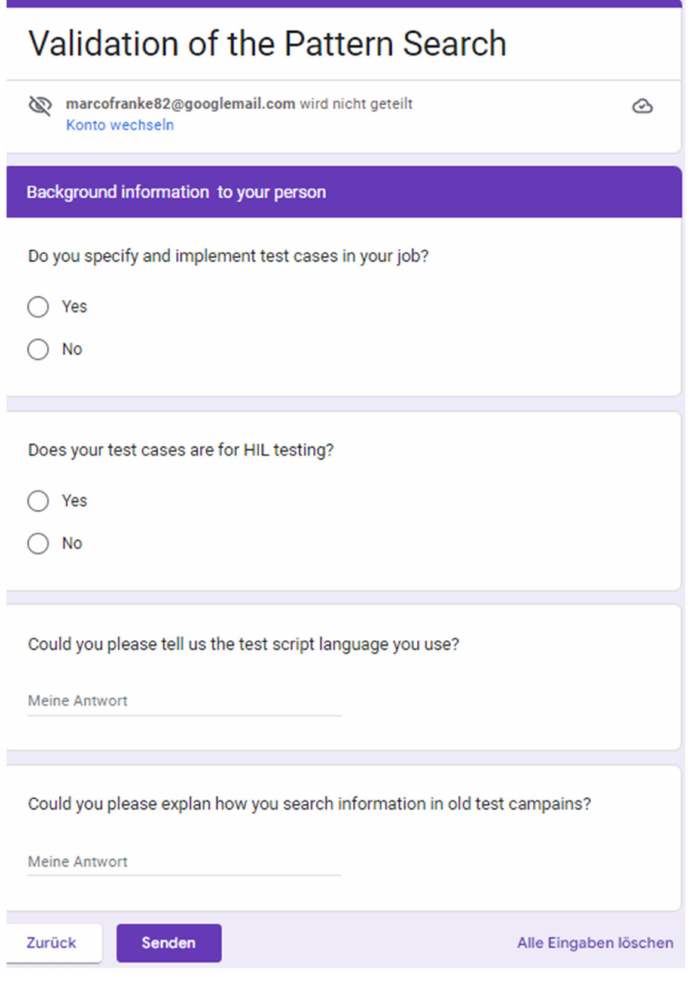
Figure 21. Page three from the